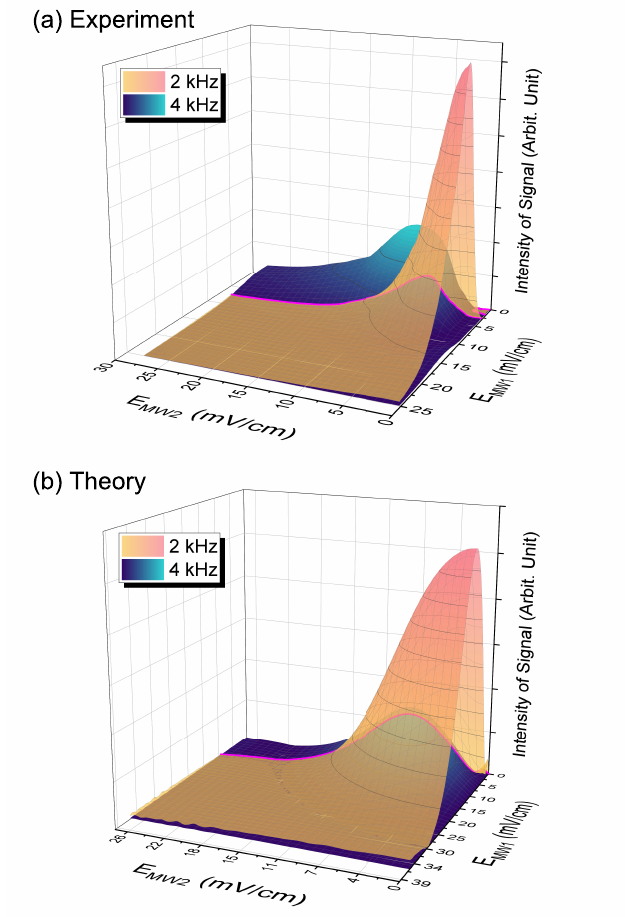
Figure 4. ( a ) Experimental and ( b ) theoretical result of the situation that the power of two channels are changed simultaneously. The gradual pink surface represents the variation of ω 1 = 2 × 2 π kHz frequency component, and the gradual dark blue surface signifies the ω 2 = 4 × 2 π kHz frequency component. The magenta line is the intersection of two surfaces, which means the intensity of two frequency component are equal when the work point is set on this line. Whether from the experimental observation or the theoretical simulation, we can see that the influence of one channel on the optical gain reduction of the other channel is very obvious, and the theoretical and experimental results are consistent in the